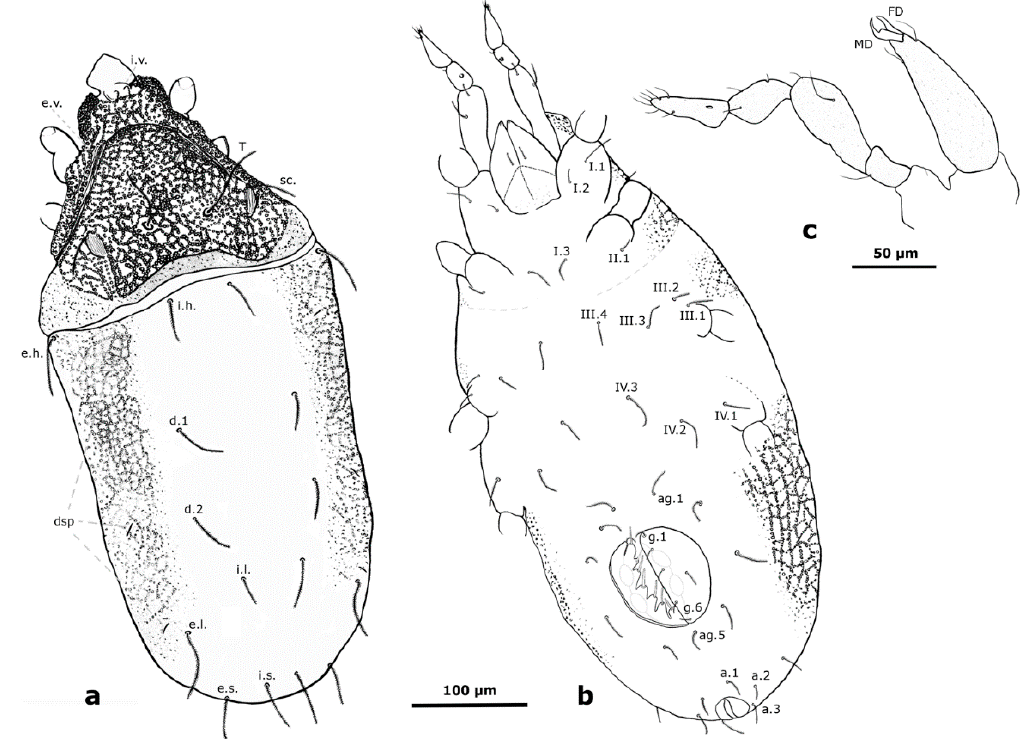
Figure 6. Stereotydeus nunatakis sp. nov. ( a ) Dorsal view; ( b ) ventral view and ( c ) lateral view of chelicera and pedipalp. Dorso-lateral slit pores (dsp); movable digit (MD) and fixed digit (FD) of chelicerae. Names of dorsal setae: internal vertical (i.v.), external vertical (e.v.), trichobothrium (T), scapular (sc.), external humeral (e.h.), internal humeral (i.h.), 1st and 2nd dorsals (d.1, d.2), internal lumbar (i.l.), external lumbar (e.l.), internal sacral (i.s.) and external sacral (e.s.). Names of ventral setae: coxal setae (I-IV), aggenital setae (ag.), genital setae (g.) and anal setae (a.).